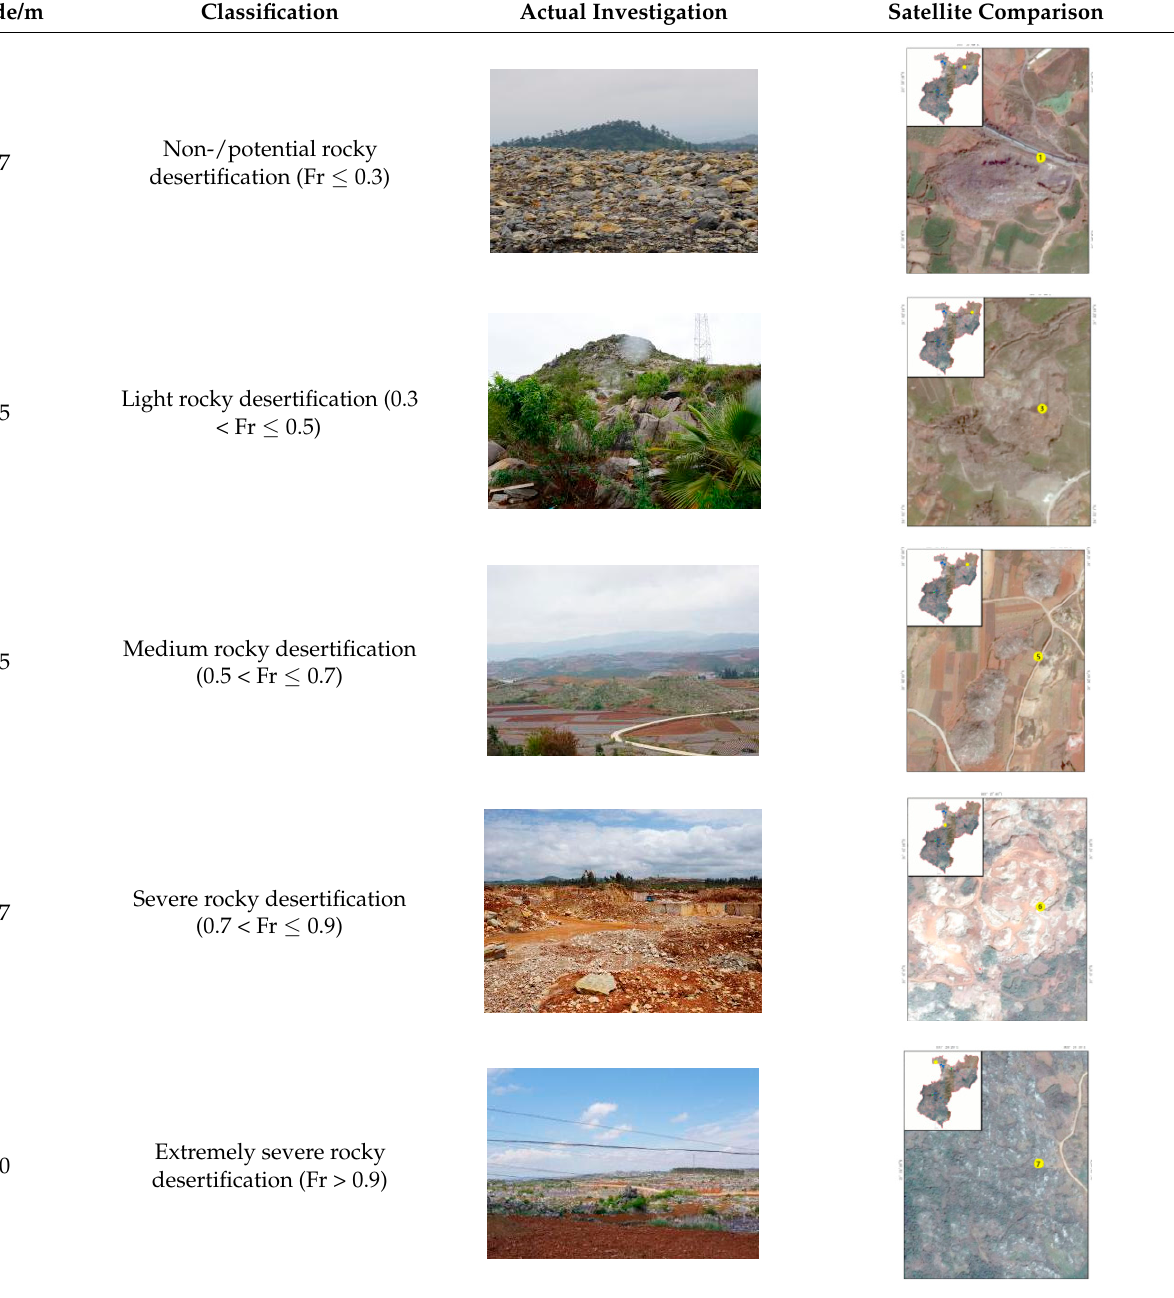
Table 1. Actual investigation of the rocky desertification degree in the study area.